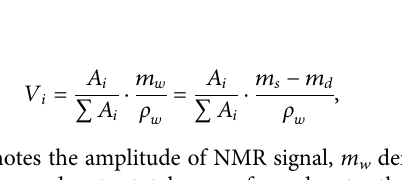
Frontiers in Earth Science |